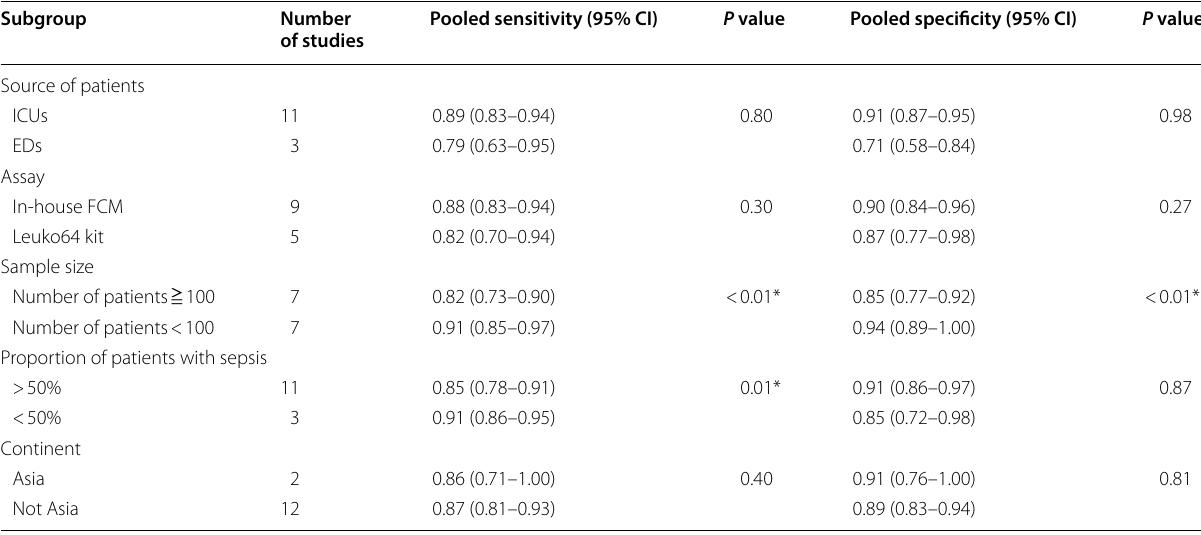
EDs emergency departments, FCM flow cytometry, ICUs intensive care